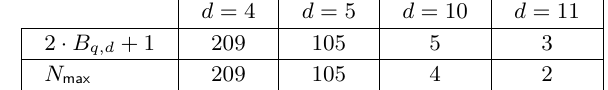
Table 7: Upper-bound on the number of candidates, and maximum number of candidates N max , for q =